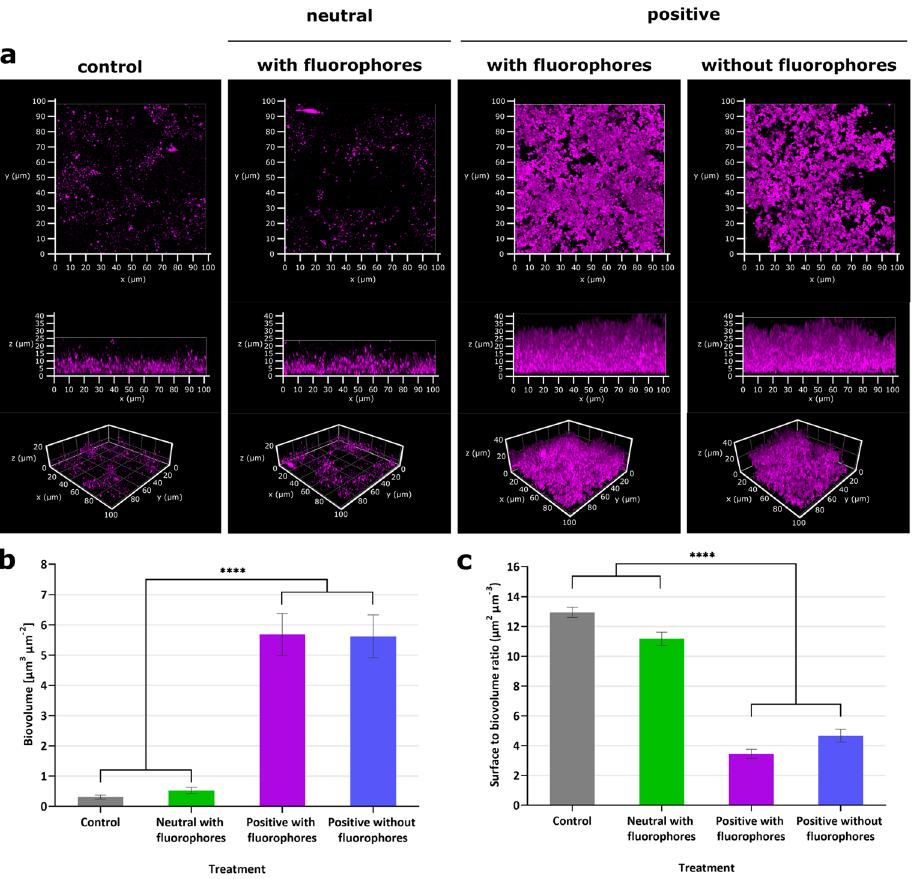
Fig. 1 The charge of nanosensors can in fl uence the bio fi lm formation of P. aeruginosa PAO1-N. Differently charged nanoparticles at 1 mg mL − 1 were incubated with P. aeruginosa PAO1-N under static conditions. Quantitative Comstat analysis of the bio fi lm images were performed using ImageJ. a Representative confocal images of P. aeruginosa PAO1-N stained with CellMask TM without the addition of nanoparticles (left panel), grown with neutral polyacrylamide nanosensors (left central panel), with positively charged polyacrylamide nanosensors containing fl uorophores (right central panel) or with positively charged polyacrylamide nanoparticles without fl uorophores (right panel). The top row is a 3D view from the top of the bio fi lm; the bottom row shows a 3D view from the front of the bio fi lm. Graphs represent b biovolume and c surface to biovolume ratio. Error bars represent standard deviation measured for different bio fi lm images, where n = 10 (control), n = 7 (neutral nanosensors and positive nanoparticles without dyes) and n = 8 (positive nanosensors), with p < 0.0001 represented by **** (ordinary one-way ANOVA). The same number of replicas were visually